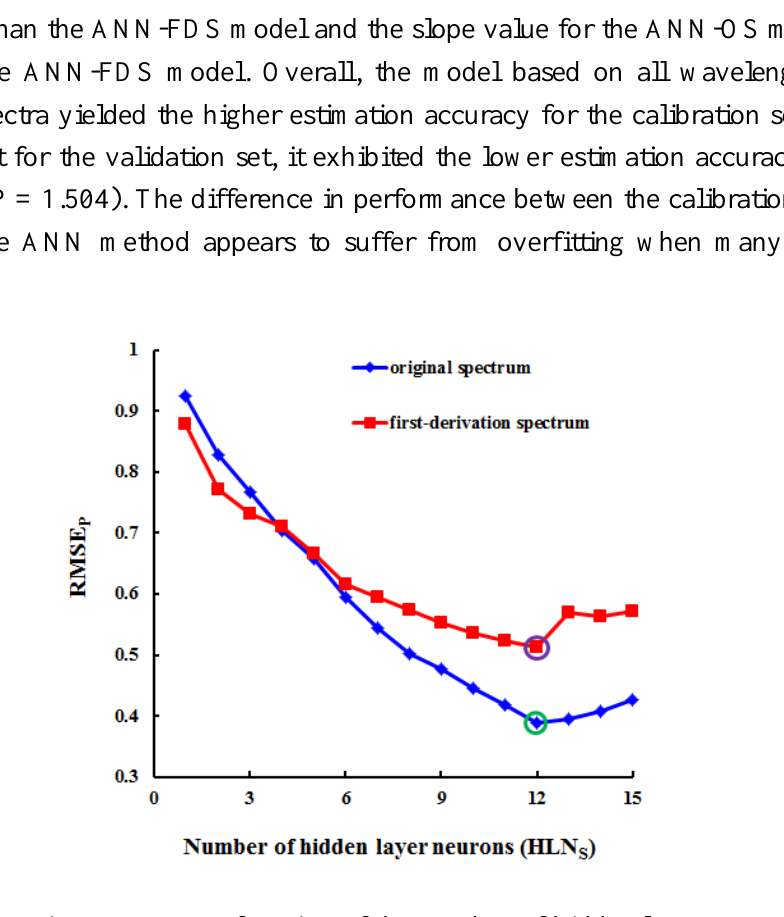
Figure 8. Changes in RMSE P as a function of the number of hidden layer neurons (HLNs) for the original and first derivative canopy spectra. Table 7. The best-performing artificial neural networks (ANNs) -based LNC models for the calibration and validation